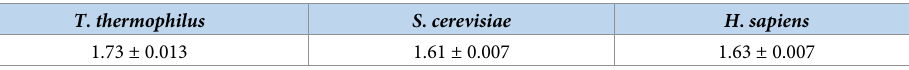
Table 2. Exponents to the log-log plots in Fig